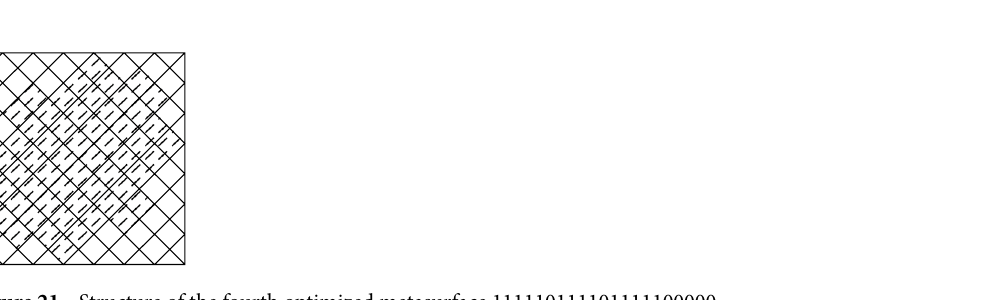
Figure 21. Structure of the fourth optimized metasurface